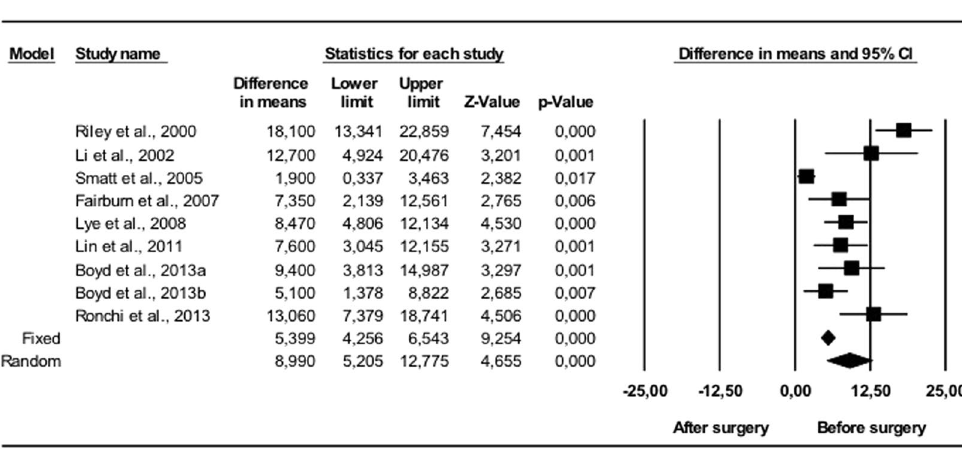
Figure 5. Changes in O2 Sat (%). Increase in oxygen saturation index following bimaxillary advancement surgery. Meta-analysis.